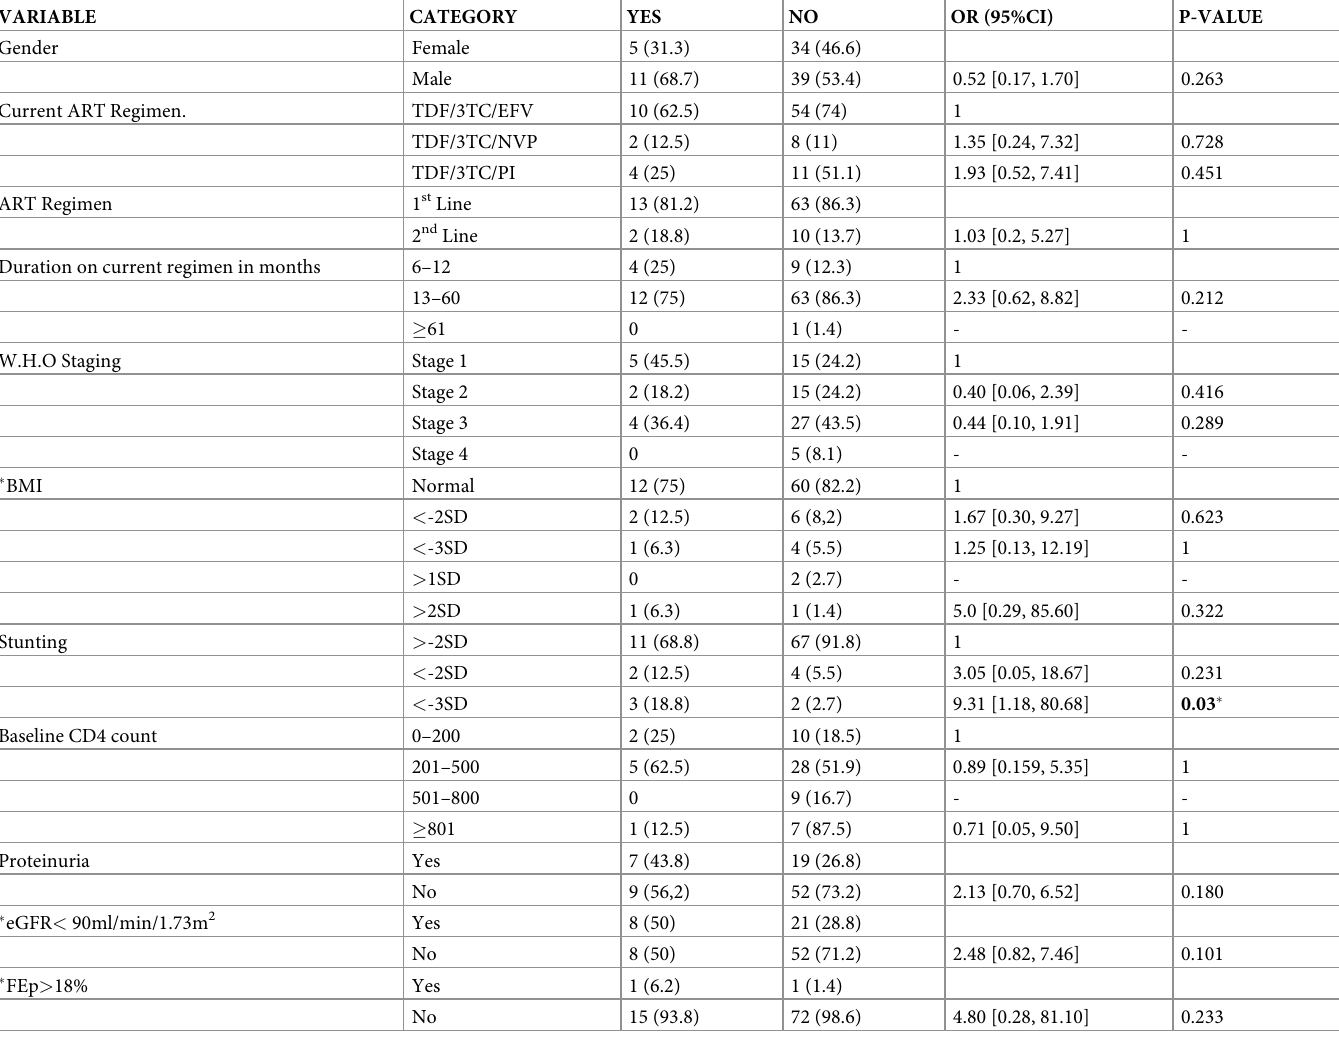
Table 4. Factors associated with hypophosphatemia in children < 14 years on TDF regimen for at least 6